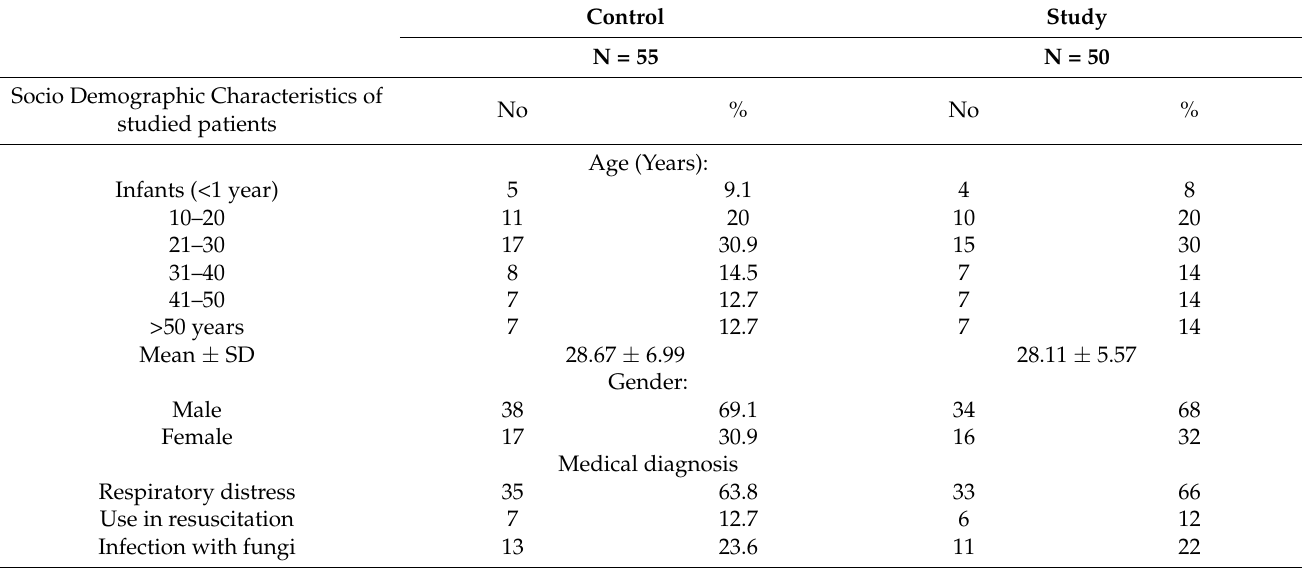
Table 2. Distribution of studied patients in relation to their characteristics (N = 105). Control